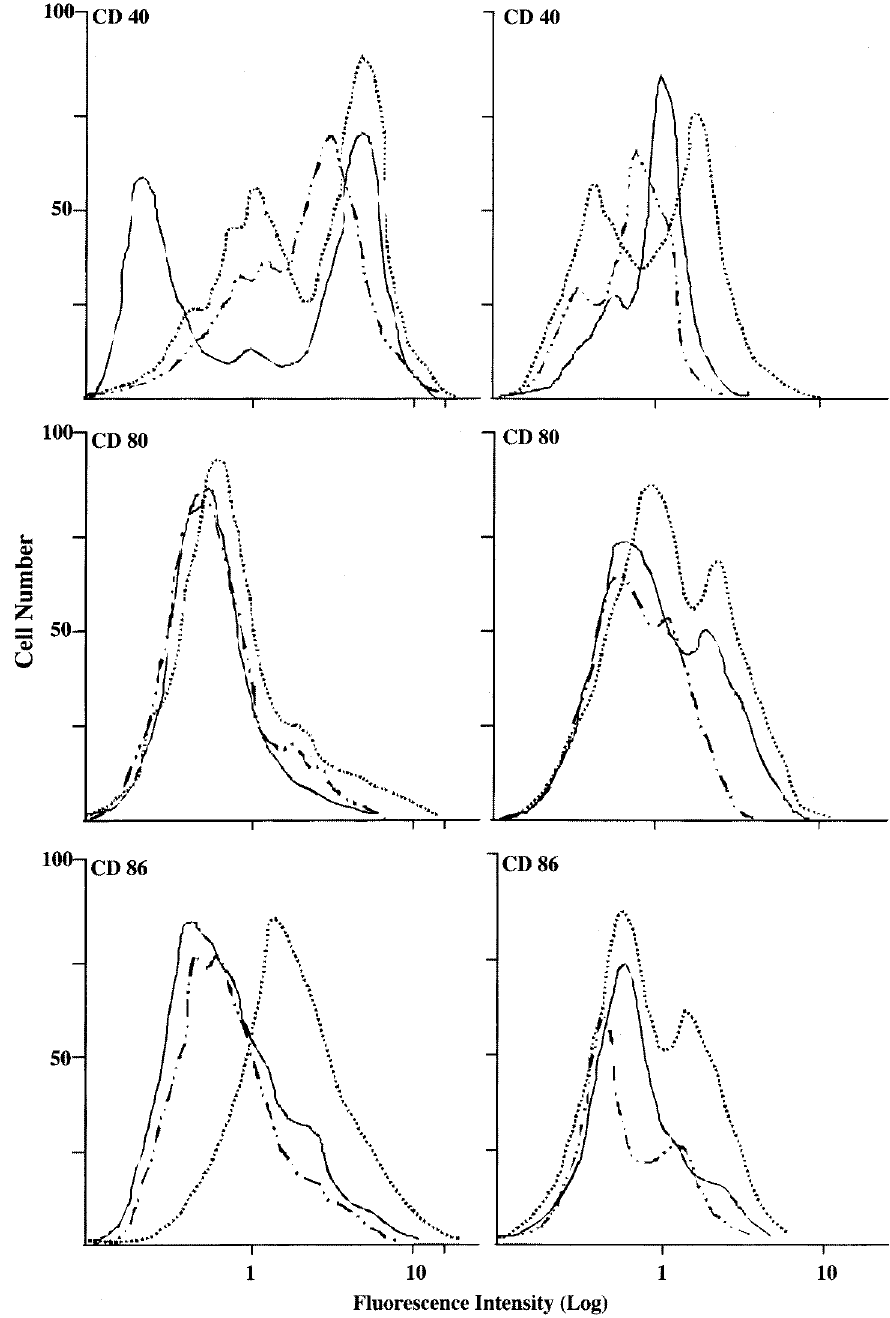
FIG. 7. Influence of oral RXM treatment for 8 weeks on co-stimulatory molecule expressions induced by antigenic stimulation in vivo . BALB/c mice were immunized by intraperitoneal injection with 8.0 m g/ml of hemocyanin absorbed to 4.0mg of aluminum hydroxide in a volume of 0.5ml. The mice were orally administered with 2.5mg/kg of RXM once a day for 8 weeks starting 7 days after immunization. Splenic B cells were prepared from mice 24h after challenging immunization. The expression was analyzed by flow cytometer: (____ ) non-treated and non-challenged control, (. . . . .) non-treated and challenged, (_ . . _ . . _ ) treated and challenged. Left panels, non-immunized mice; right panels, immunized